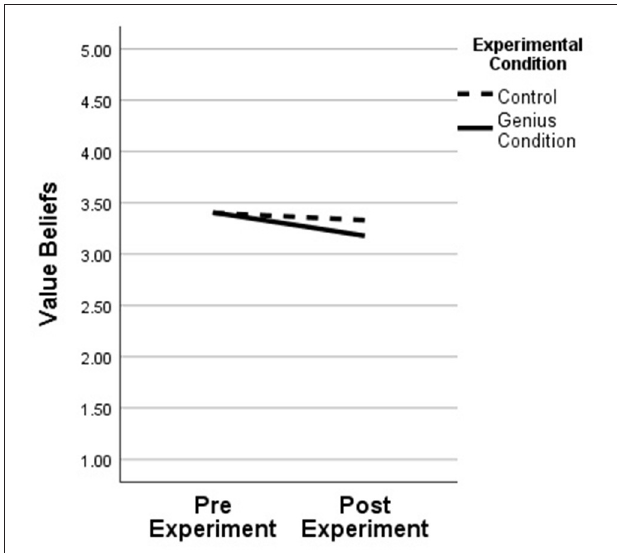
FIGURE 3 | Value beliefs pre- and post- experiment, by condition. Controlling for student math